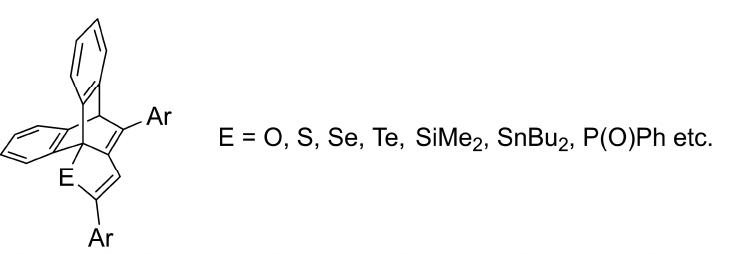
Figure 1. 1,4-diaryl-1,3-butadiene derivatives bearing a rigid dibenzobarrelene